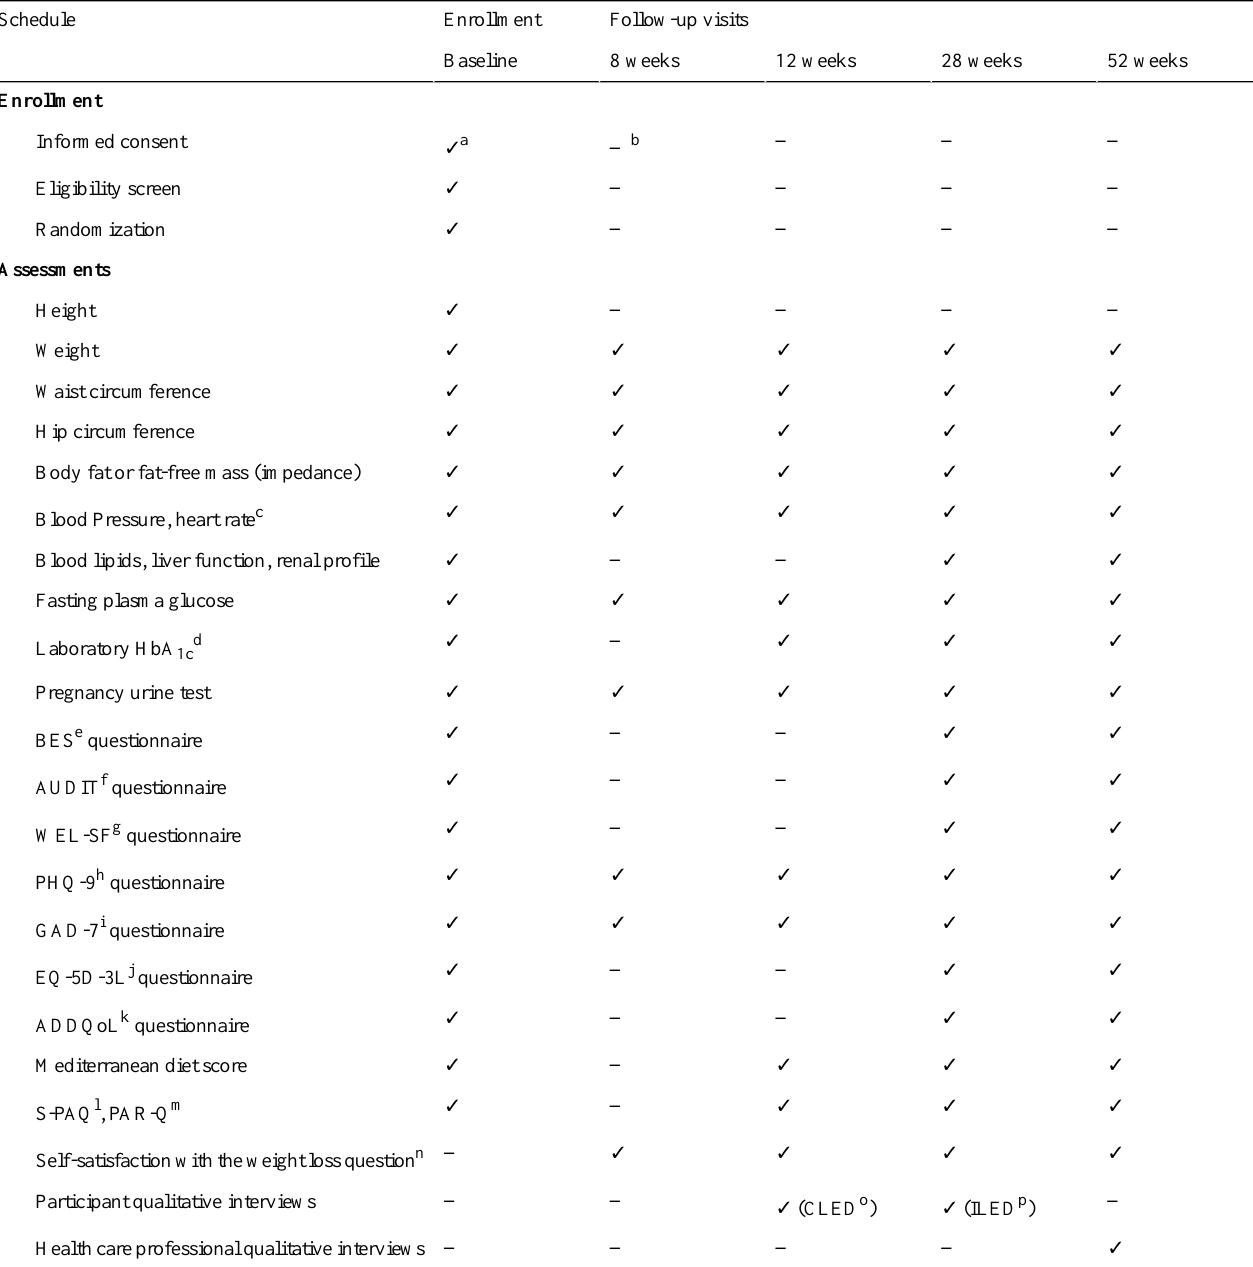
Table 1. Schedule of enrollment and assessments.